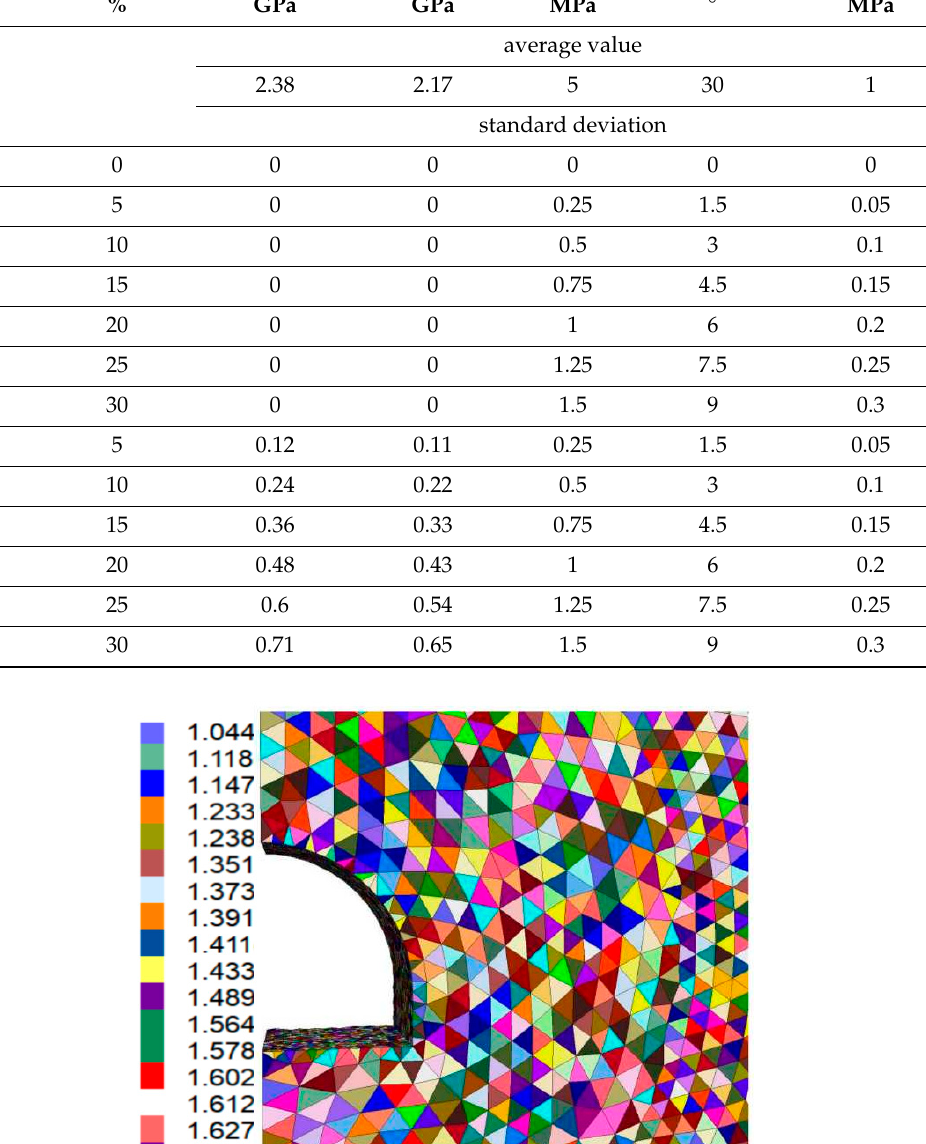
Table 1. List of the adopted material properties for variants, taking into account the variability of strength parameters.